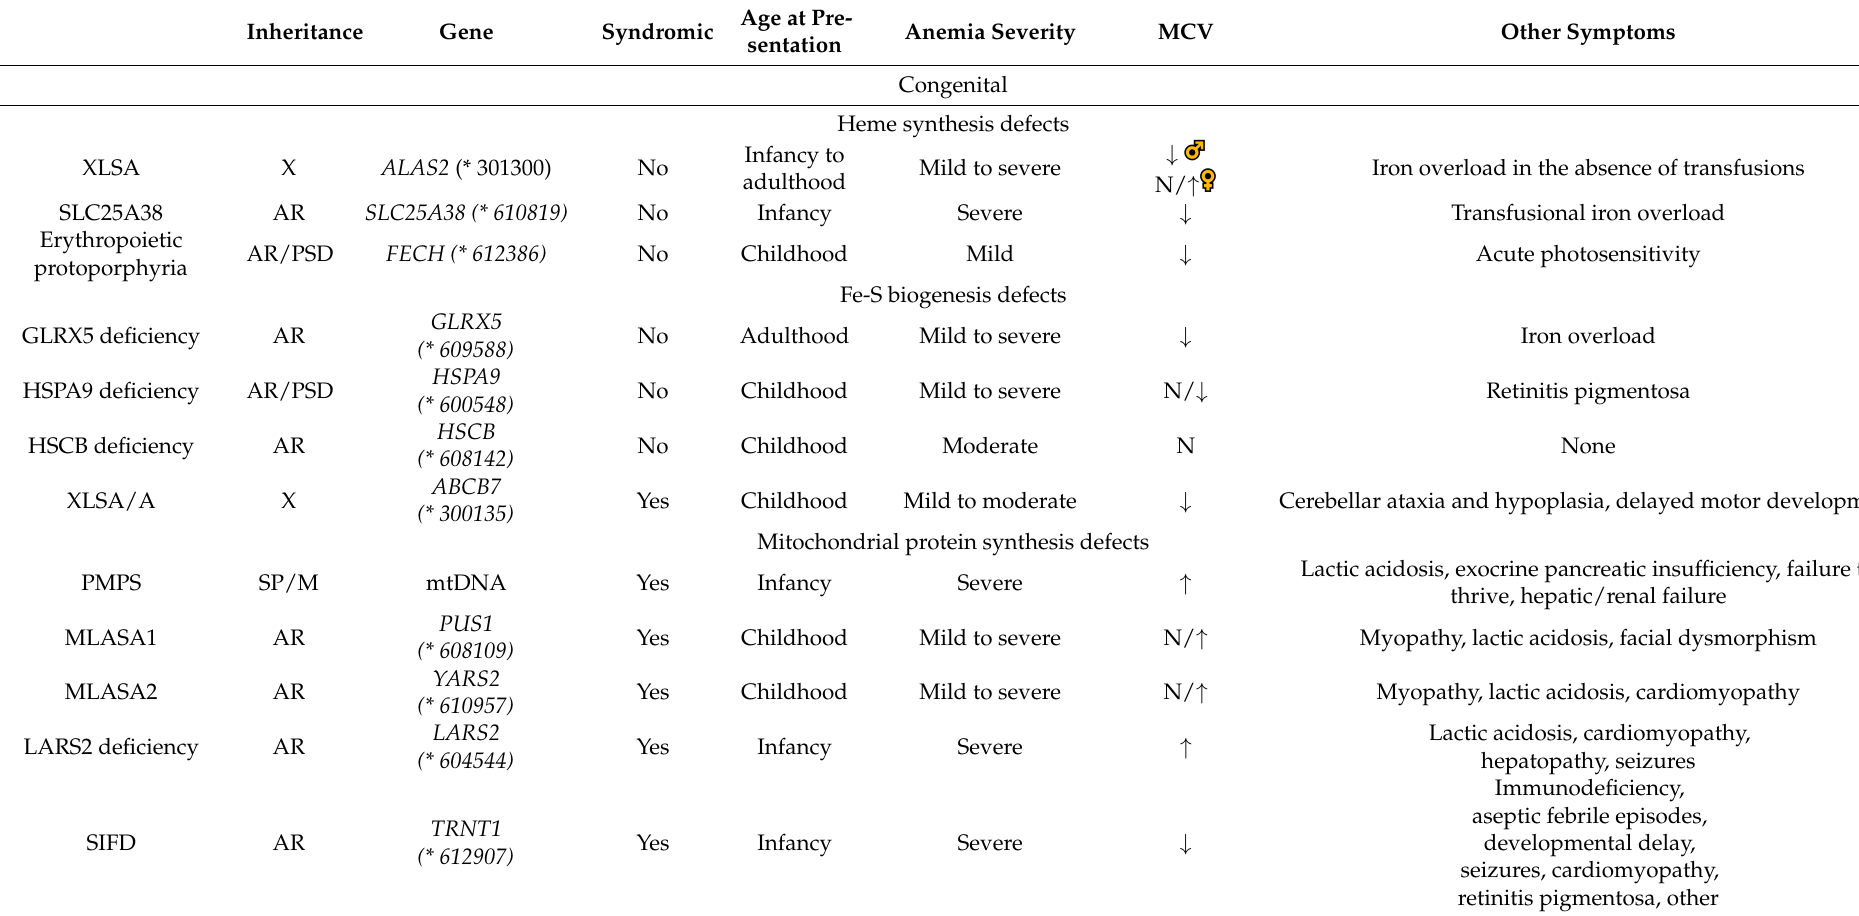
Table 1. Genetic and phenotypic characteristics of sideroblastic anemias (Adapted from Ducamp et al. [1]).